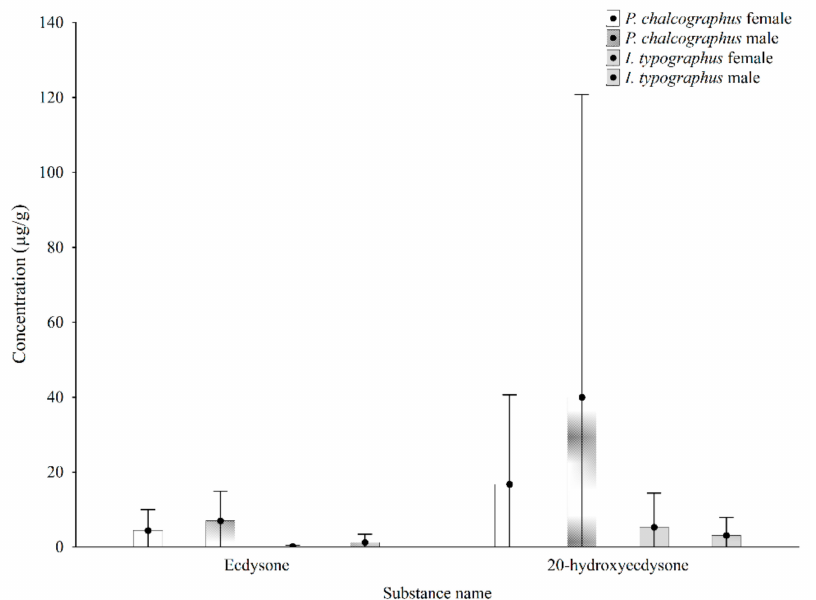
Figure 6. Mean ( ± SD) concentration of ecdysone and 20-hydroxyecdysone in the bodies of the most dangerous Norway spruce bark beetle species (the number of samples for each insect species was N =